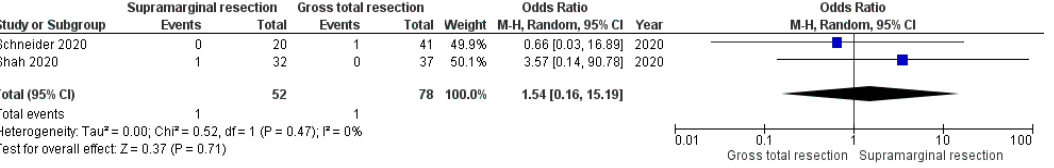
Figure 6. Forest plot displaying odds ratio and 95% CI estimates for postoperative CSF leaks in studies [29,33] evaluating SMR compared to GTR in GB patients. X-axis locations of squares represent the odds ratio; the bigger the square, the greater the weight due to sample size. The diamond corresponds to the odds ratio of the overall data.